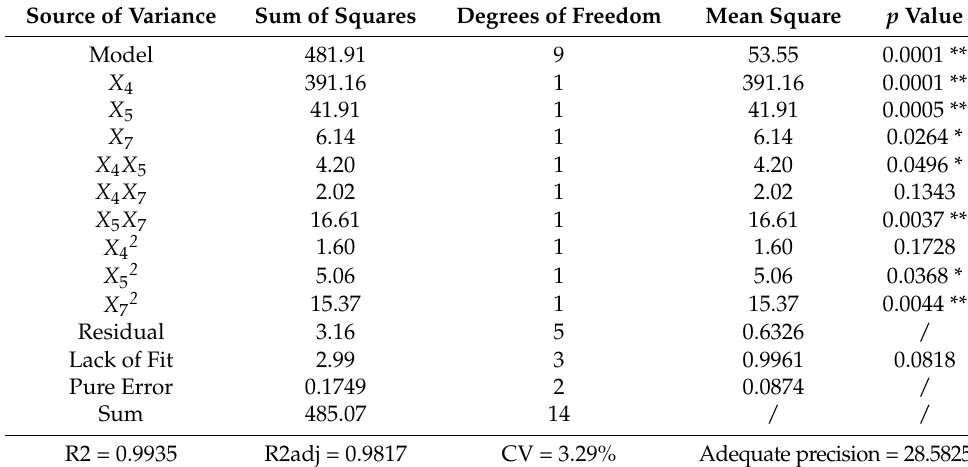
Table 9. Box-Behnken test regression model analysis of variance.